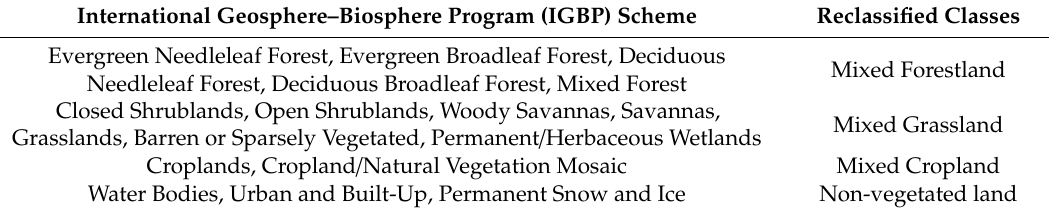
Table 1. Reclassification of the moderate-resolution imaging spectro-radiometer (MODIS) product